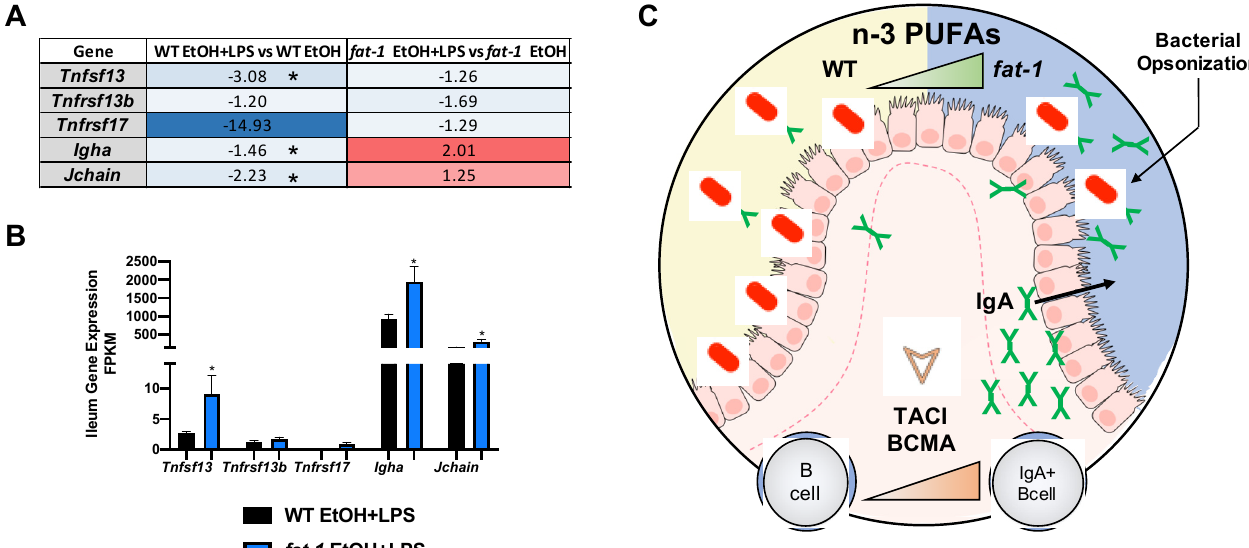
Figure 7. Increased n-3 PUFAs enhanced APRIL-signaling gene expression and IgA + B-Cell markers. ( A ) Heatmap fold-change values for APRIL signaling genes and IgA genes for the WT EtOH + LPS vs. WT EtOH comparison and the fat-1 EtOH + LPS vs. fat-1 EtOH comparison. ( B ) APRIL signaling and IgA gene expression for WT EtOH + LPS and fat-1 EtOH + LPS-treated mice. ( C ) Graphical representation of enhanced APRIL signaling and IgA + B cells in the ileum of mice with n-3 PUFA enrichment. Statistical significance ( p < 0.05) is denoted by an *.